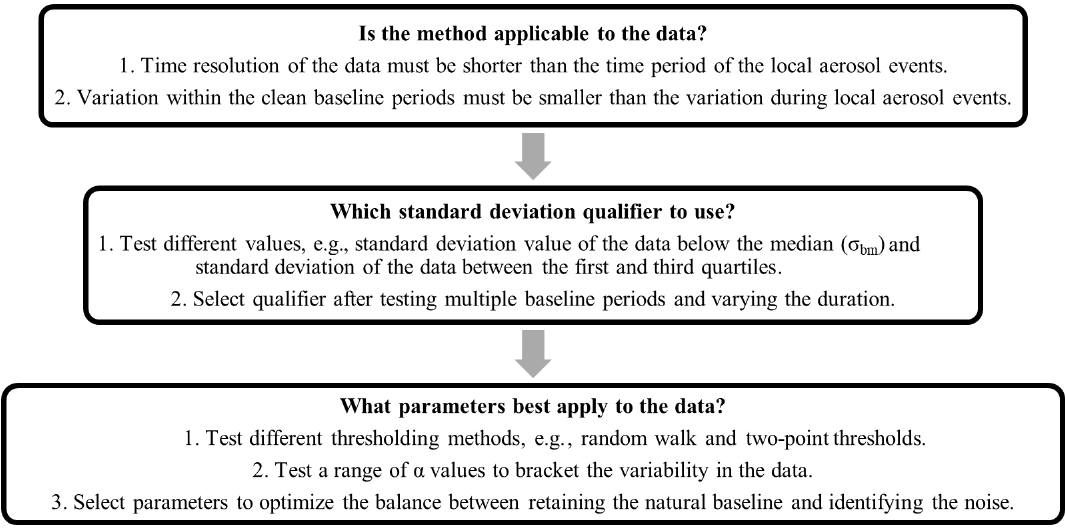
Figure 2. Flow chart to apply the standard deviation algorithm to high-time-resolution aerosol